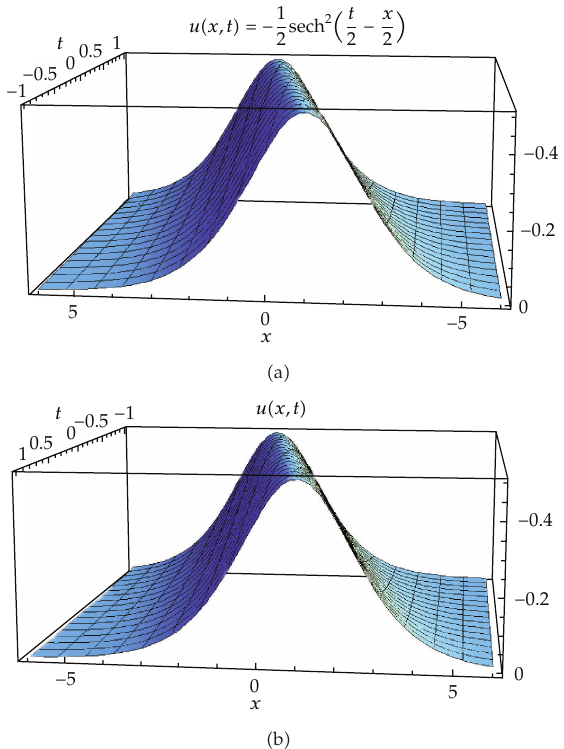
Figure 2: Comparison of the exact solution with the HAM solution of u (cid:2) x,t (cid:3) , when ħ (cid:8) − 1: (cid:2) a (cid:3) exact solu- tion, (cid:2) b (cid:3) HAM